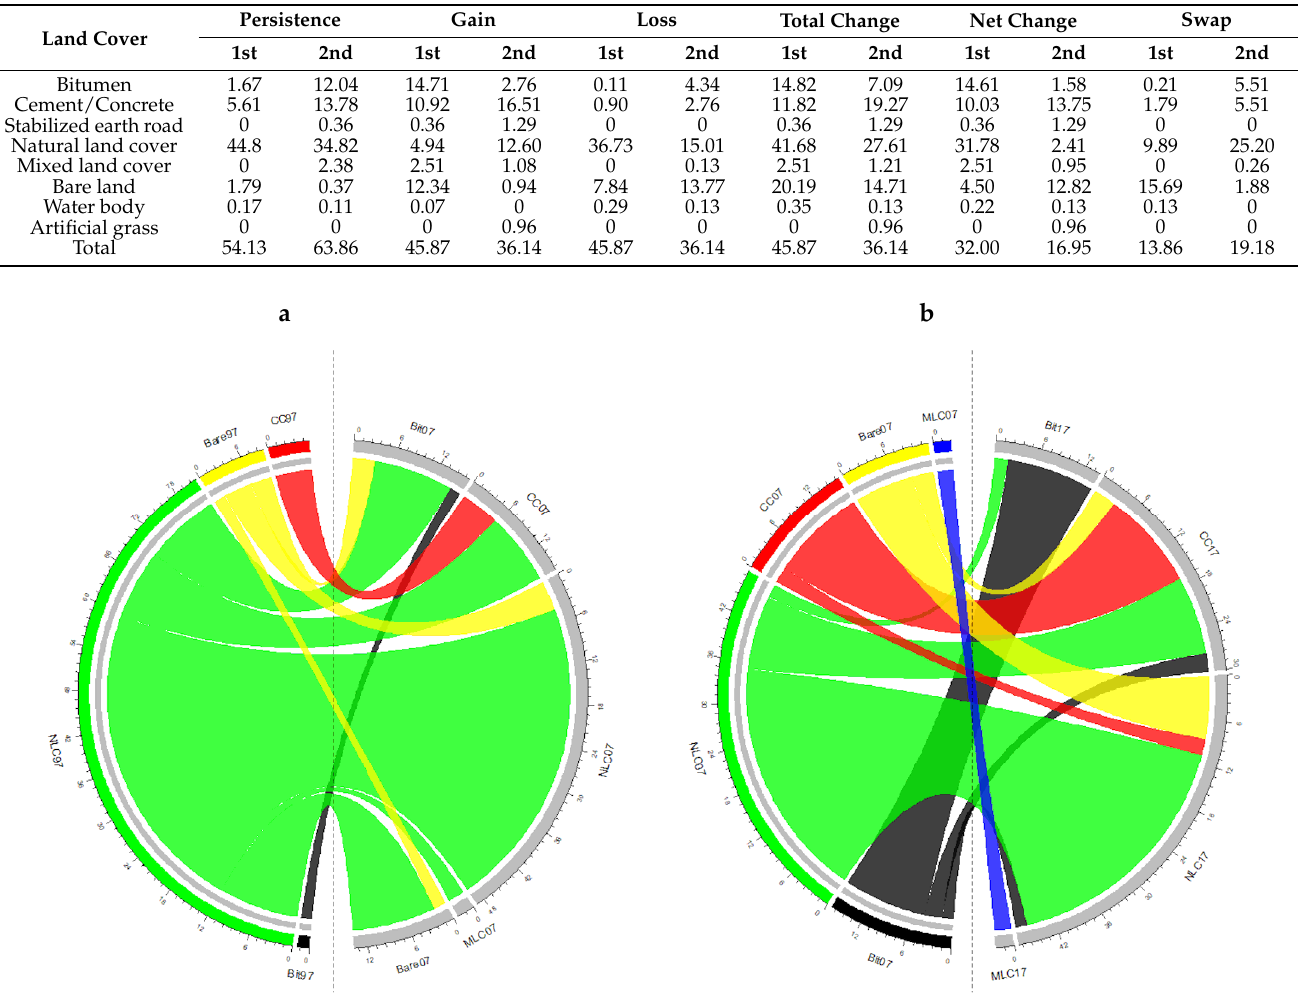
Figure 3. Chord diagram showing the major interrelations and changes between 1997–2007 ( a ) and 2007–2017 ( b ). Land cover abbreviations used in the diagram: Bare: bare soil; CC: cement/concrete; Bit: bitumen; ML: mixed land cover; NL: natural land cover. Years: 97 (1997), 07 (2007), 17 (2017).